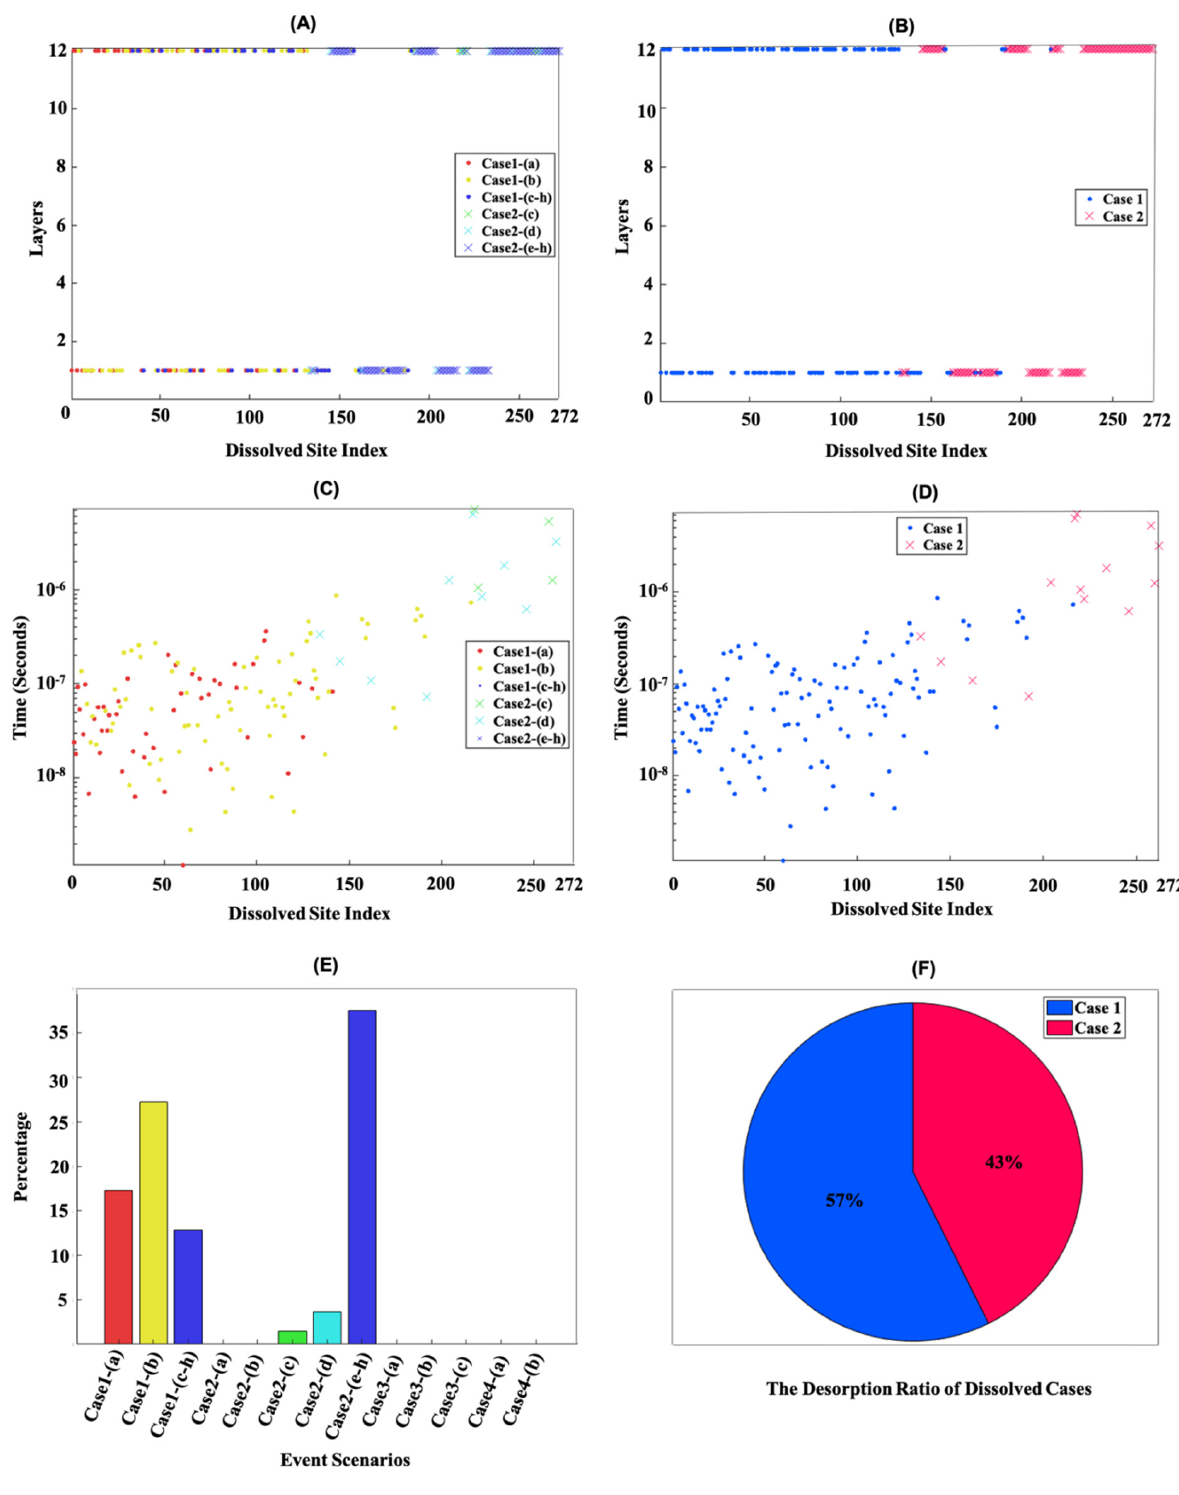
Figure 3. Pivotal details obtained through implementation of KMC upscaling approach after 10% β -C 2 S crystal dissolution (Figure 2B) by applying periodic boundary conditions (PBCs) along the Y and Z axes. ( A , B ) Illustration of dissolved Ca and silicate monomers for different event scenarios and cases applied to the 12 layers (along the X axis) as a function of the dissolved site index. ( C , D ) Representation of the dissolution time of each site for different event scenarios and cases. ( E ) The contribution of each event scenario as a percentage. ( F ) The contribution of each case after 10% dissolution of β -C 2 S crystal.